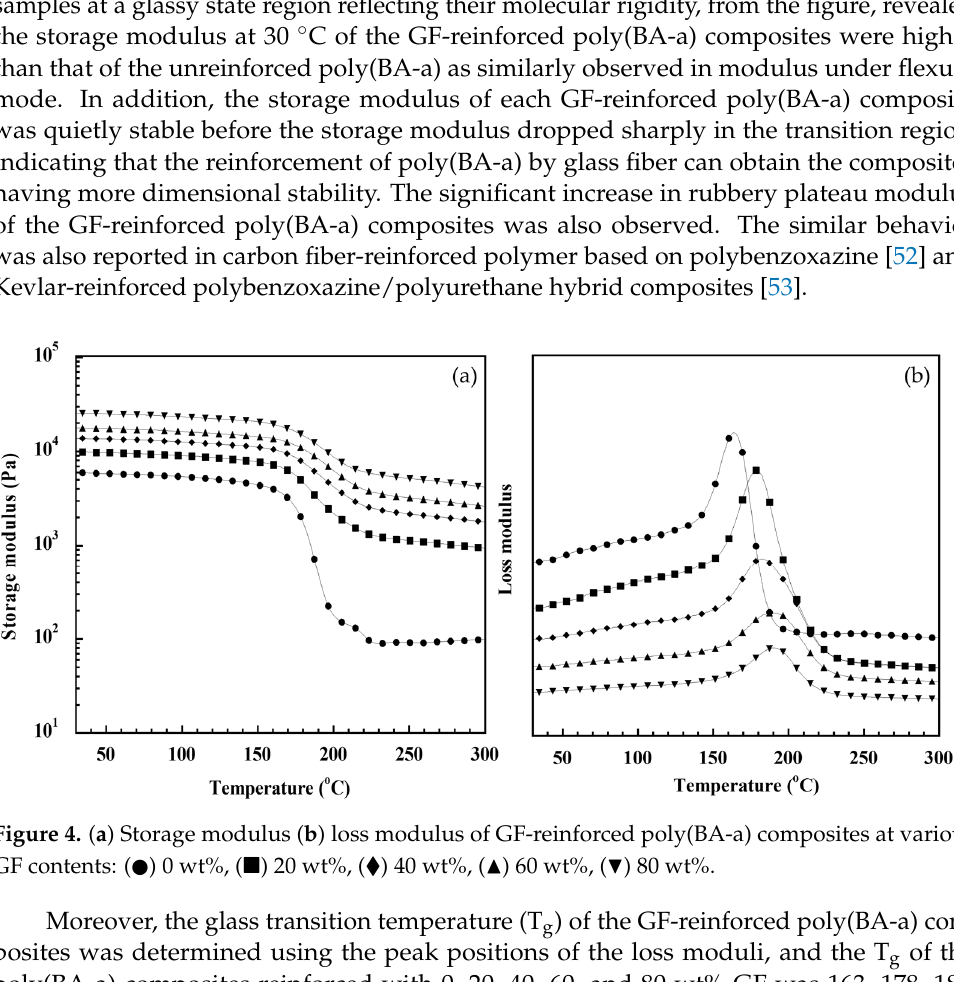
Figure 5. SEM micrographs ( a ) glass fiber morphology, ( b ) fractured surface of 80 wt% GF-rein- forced poly(BA-a) composite.